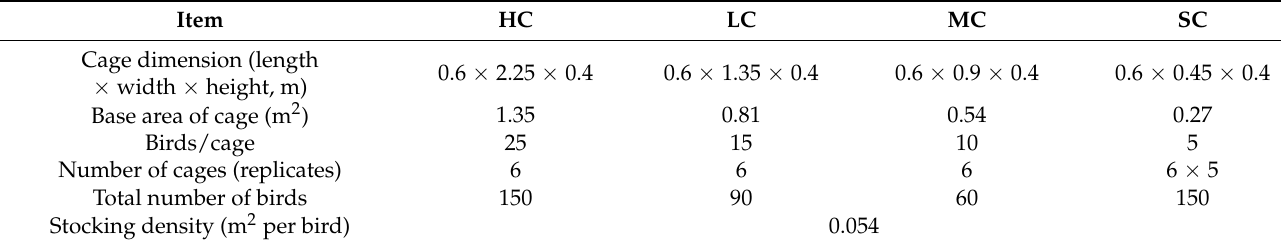
Table 1. Parameters of the experimental